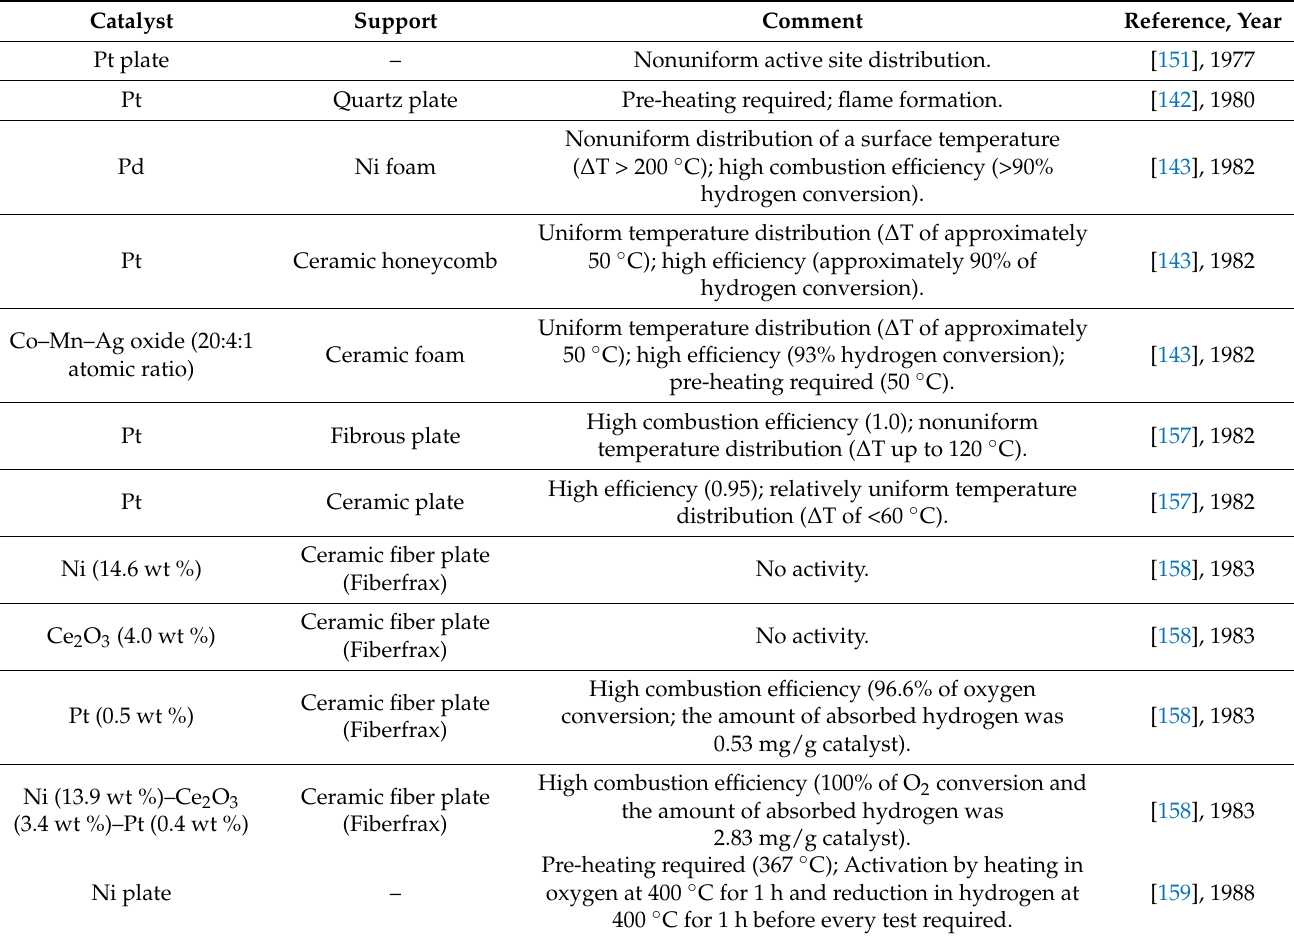
Table 2. A summary of the catalysts used for CHC